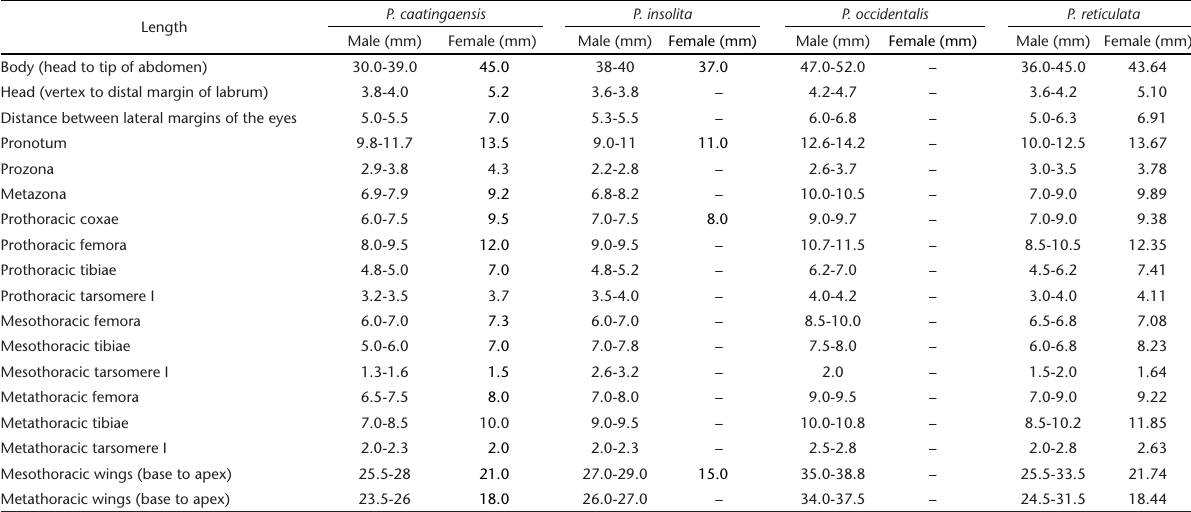
Table 1. Comparative measurements of the examined specimens of Paraphotina